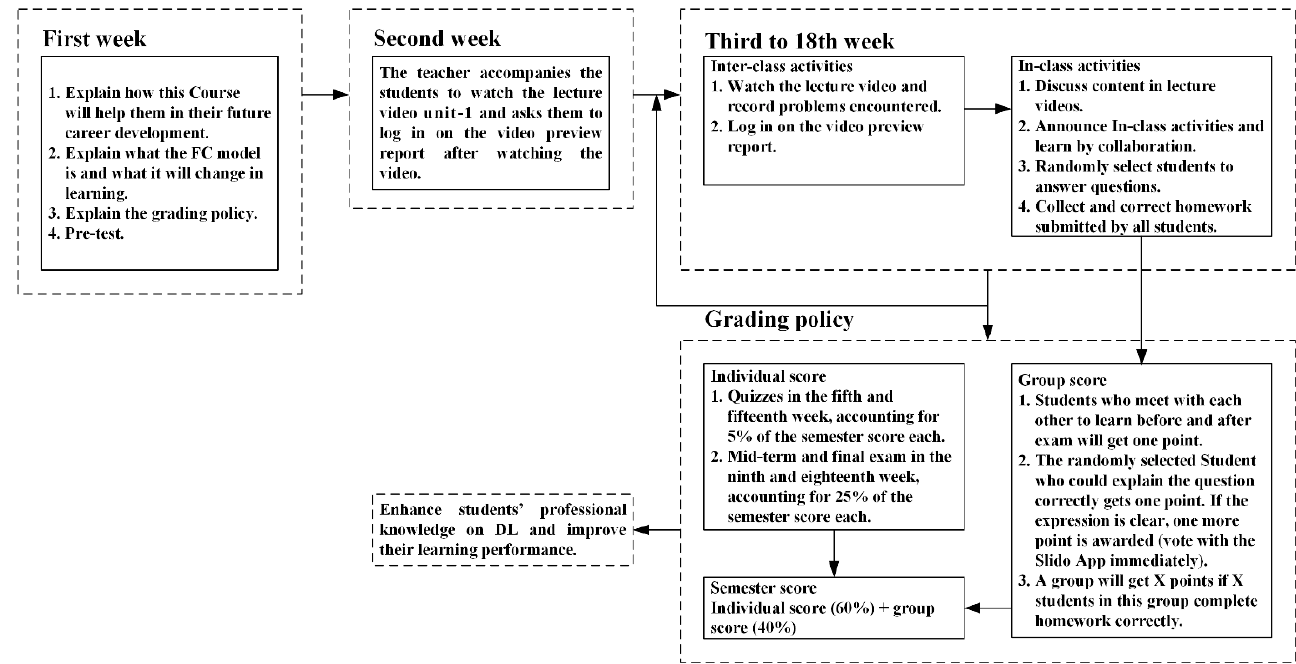
Figure 4. Structure of implementation process. Figure 6. Structure of implementation